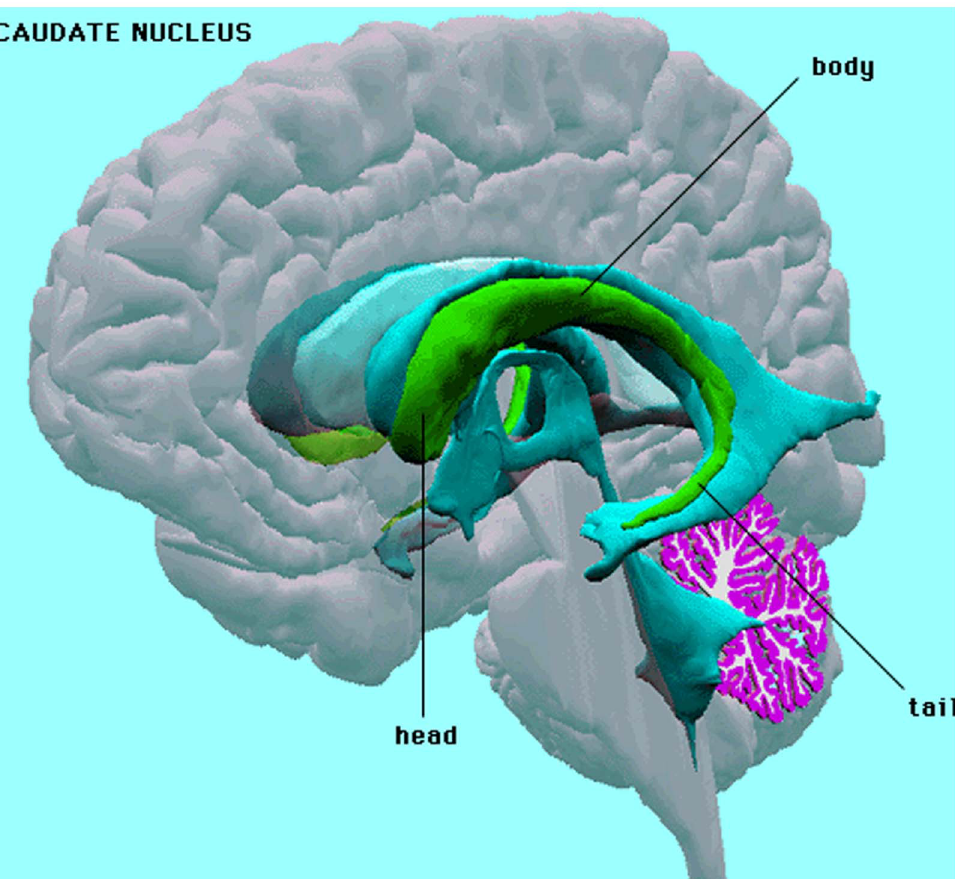
Figure 1. The Caudate Nuclei in the Human Brain.